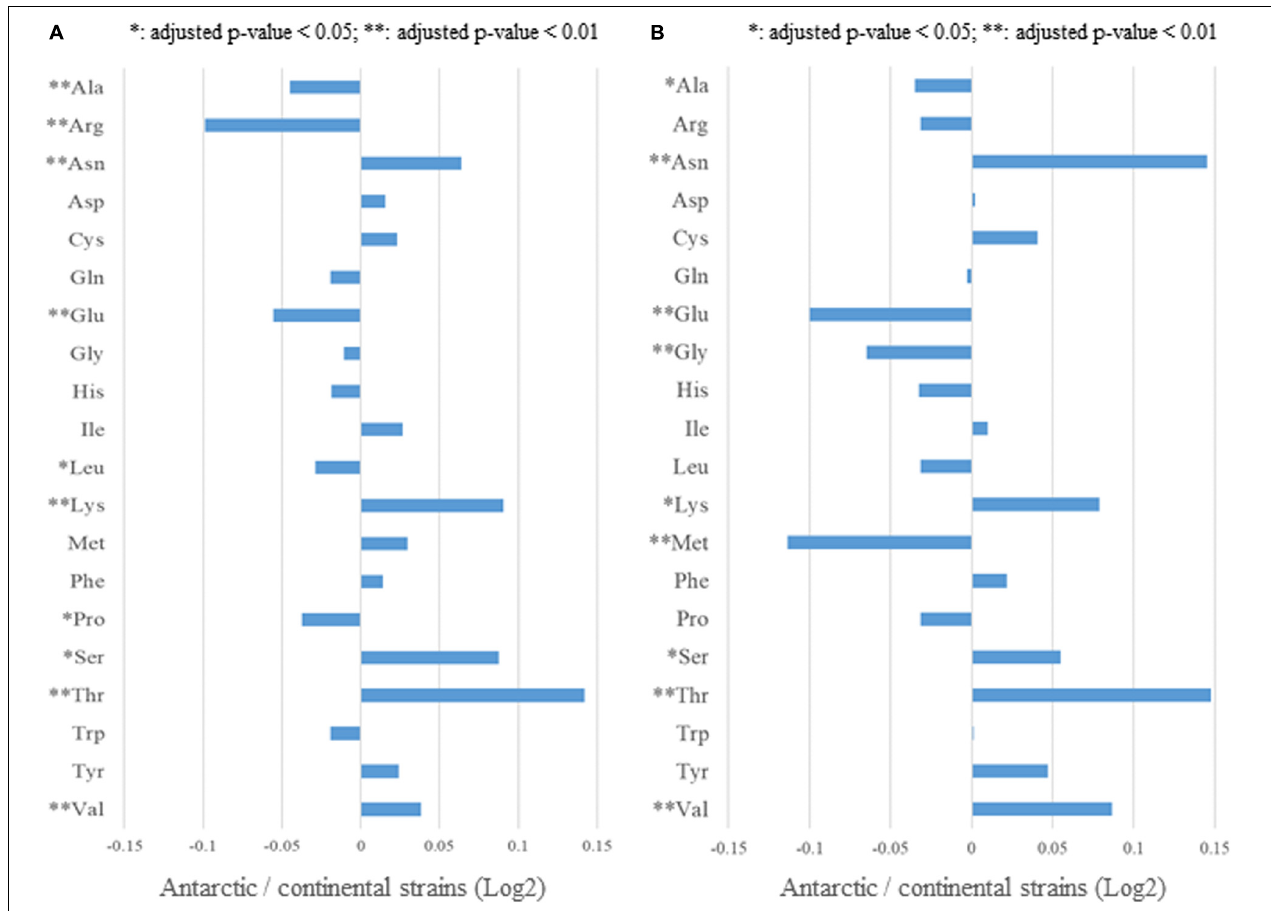
FIGURE 9 | Comparison of amino acid usage between the Antarctic and continental strains. (A) Ratio of amino acid frequencies in the housekeeping genes of the Antarctic and continental strains. Asterisks: significant difference between Antarctic and continental strains. (B) Ratio of amino acid frequencies in the strain-specific HGT candidates of the Antarctic and continental